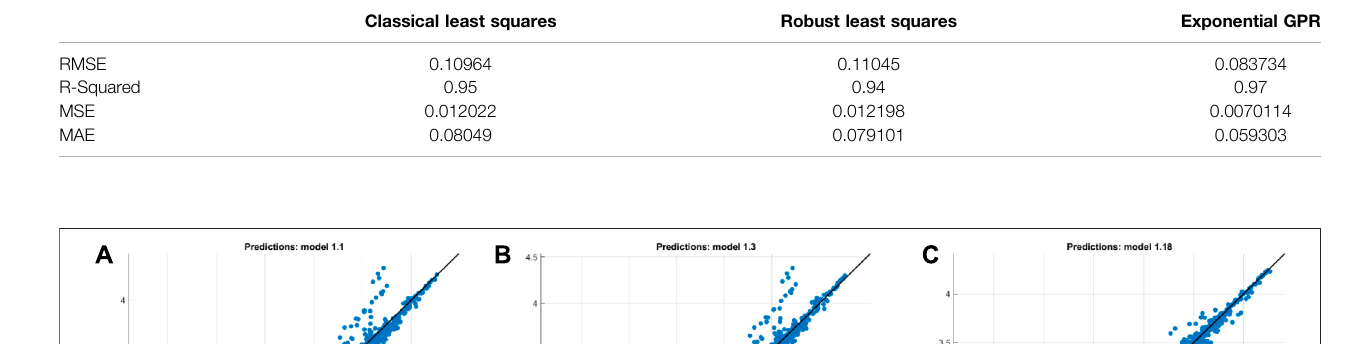
TABLE 1 | Statistical Analysis of Prediction Results.